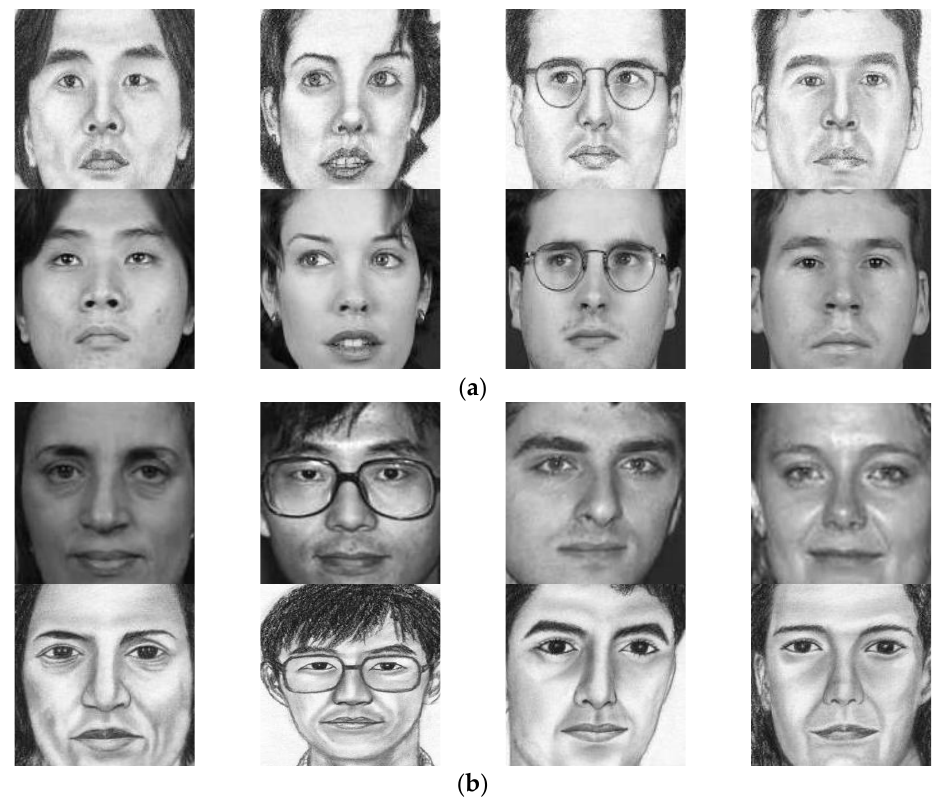
Figure 11. Sample images from ( a ) XM2VTS database, and ( b ) CUFSF database.